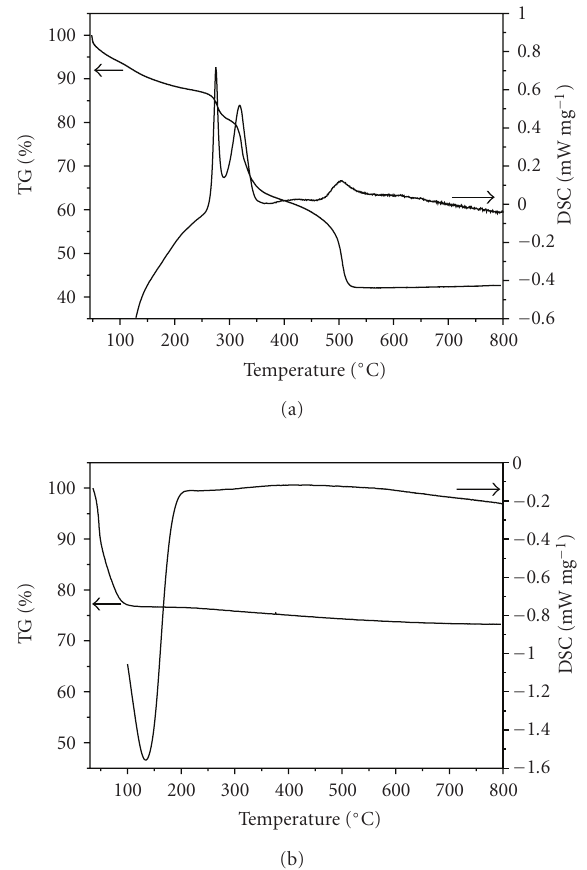
Figure 2: TG-DSC curves of the room-temperature-dried TiO 2 (a) and SiO 2 (b) gels in an air atmosphere.